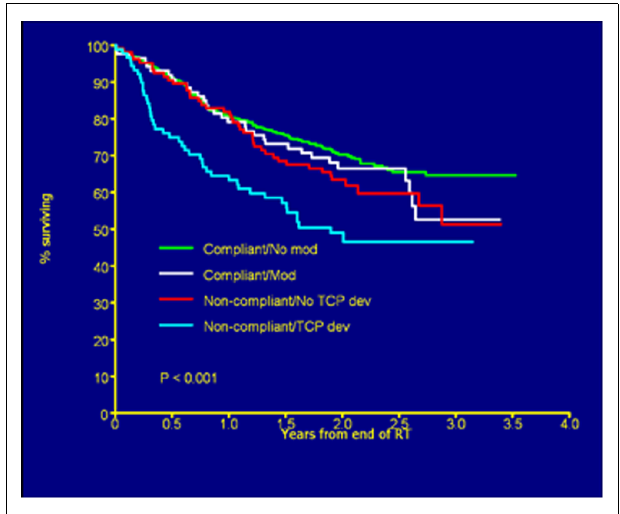
FIGURE 3 | Overall survival by deviation status. Figure as originally published in Peters etal.